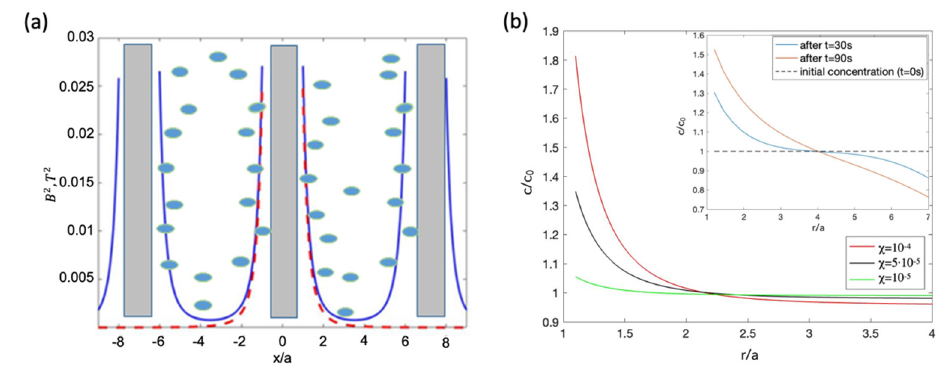
Figure 14. ( a ) Magnetic energy profile from an array of microwires magnetised along diameter (blue curves; red curves show the energy profile from a single wire) and schematics of paramagnetic NP distribution with a higher concentration near the wires. ( b ) Stationary distribution of concentration c/c 0 (normalised to initial concentration c 0 ) around a single microwire for different values of magnetic susceptibility. Inset shows the concentration distribution after a few characteristic times. r / a is the normalised polar coordinate. The calculations were performed for the parameters: D = 3 × 10 − 12 m 2 /s, χ = 10 − 4 ( for insert ) , V = 10 − 21 m 3 , a = 15 µ m, and M = 0.5